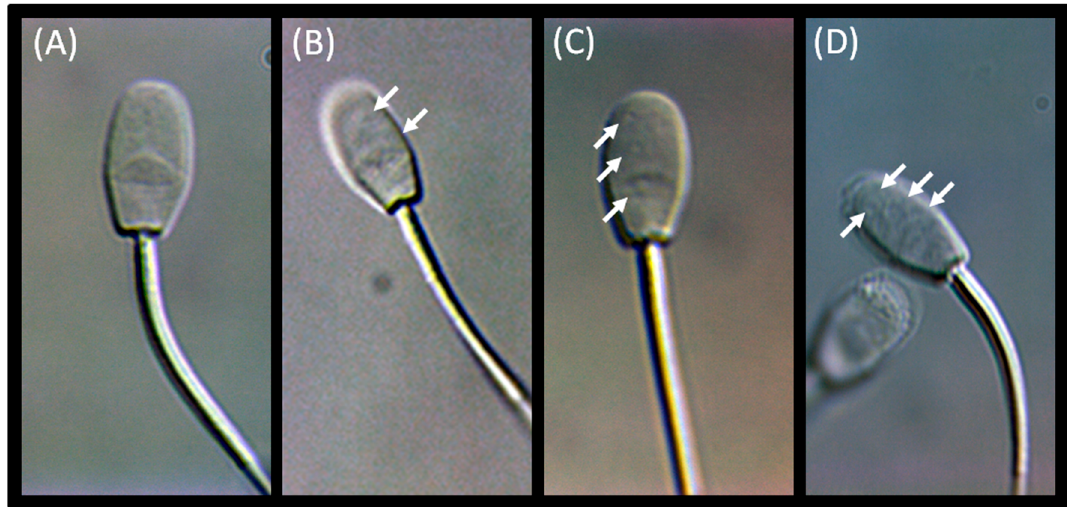
Figure 1. Microscopic images of ram sperm cells under high optical magnification (6.000–10.000×). Sperm cells represented four grades of motile sperm organelle morphology examination (MSOME): Grade I ( A ); Grade II ( B ); Grade III ( C ); Grade IV ( D ). Cytoplasmic vacuoles were marked with white arrows.